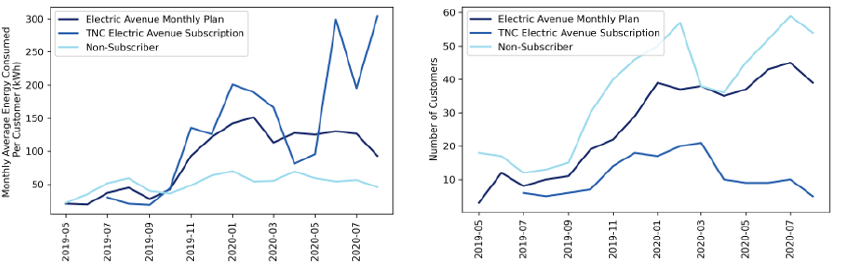
Figure 10. Average monthly energy consumption (left) and number of customers per user group (right) by user group.